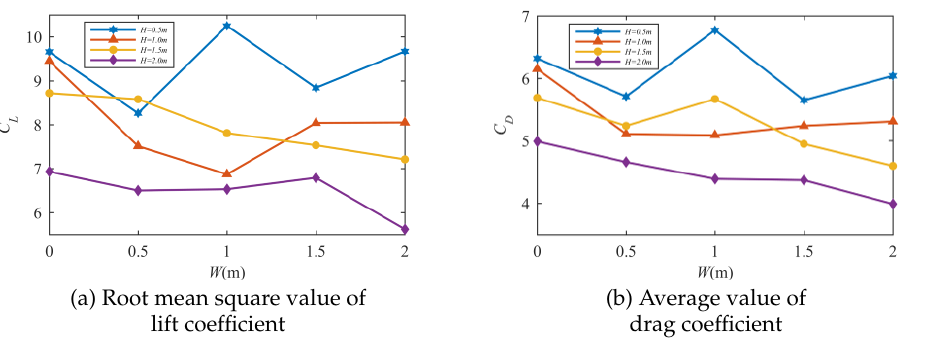
Fig. 15. Variation of aerodynamic coefficient of positive feeder under different positions of second wind-break wall